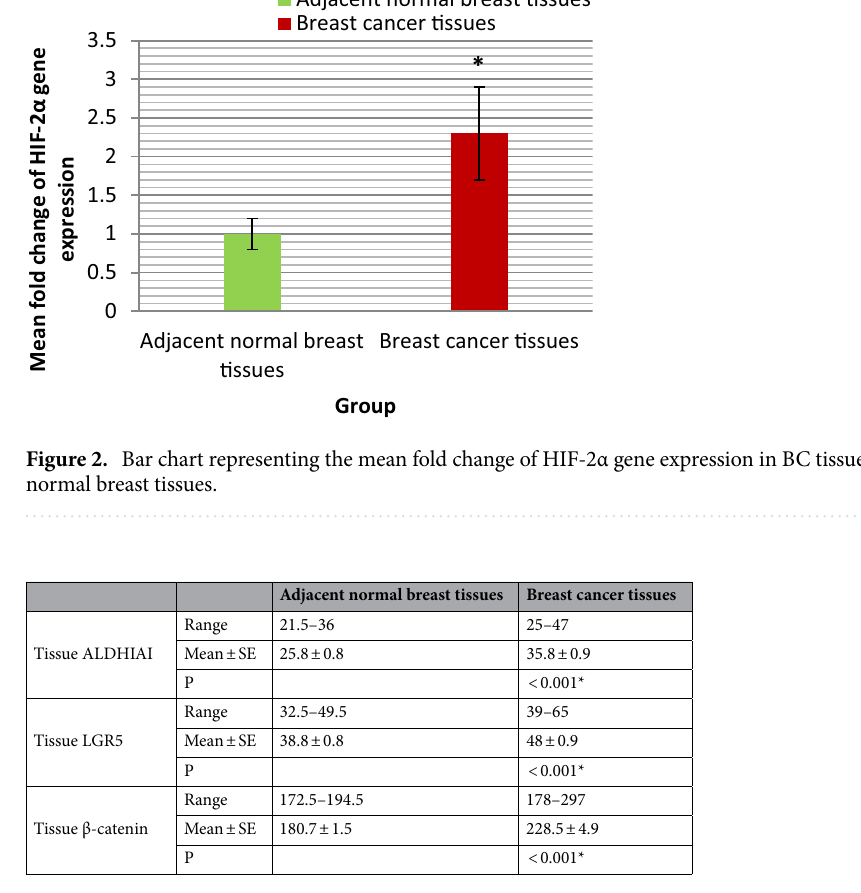
Table 2. Statistical analyses of ALDHIAI, LGR5 and β-catenin levels (pg/ml) in BC tissues and adjacent normal breast tissues. P P value for comparing between BC tissues and adjacent normal breast tissues. *Statistically significant difference at P ≤